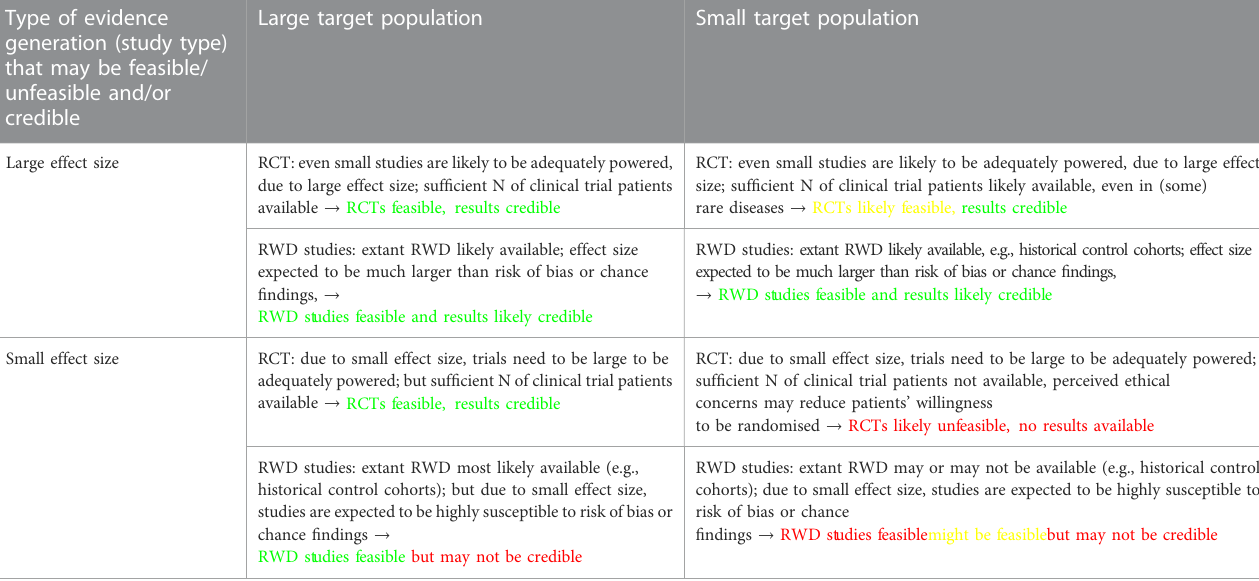
TABLE 1 Relationship between the size of clinical effect, size of target population, feasibility of different study types, and credibility of results. Type of evidence generation (study type) that may be feasible/ unfeasible